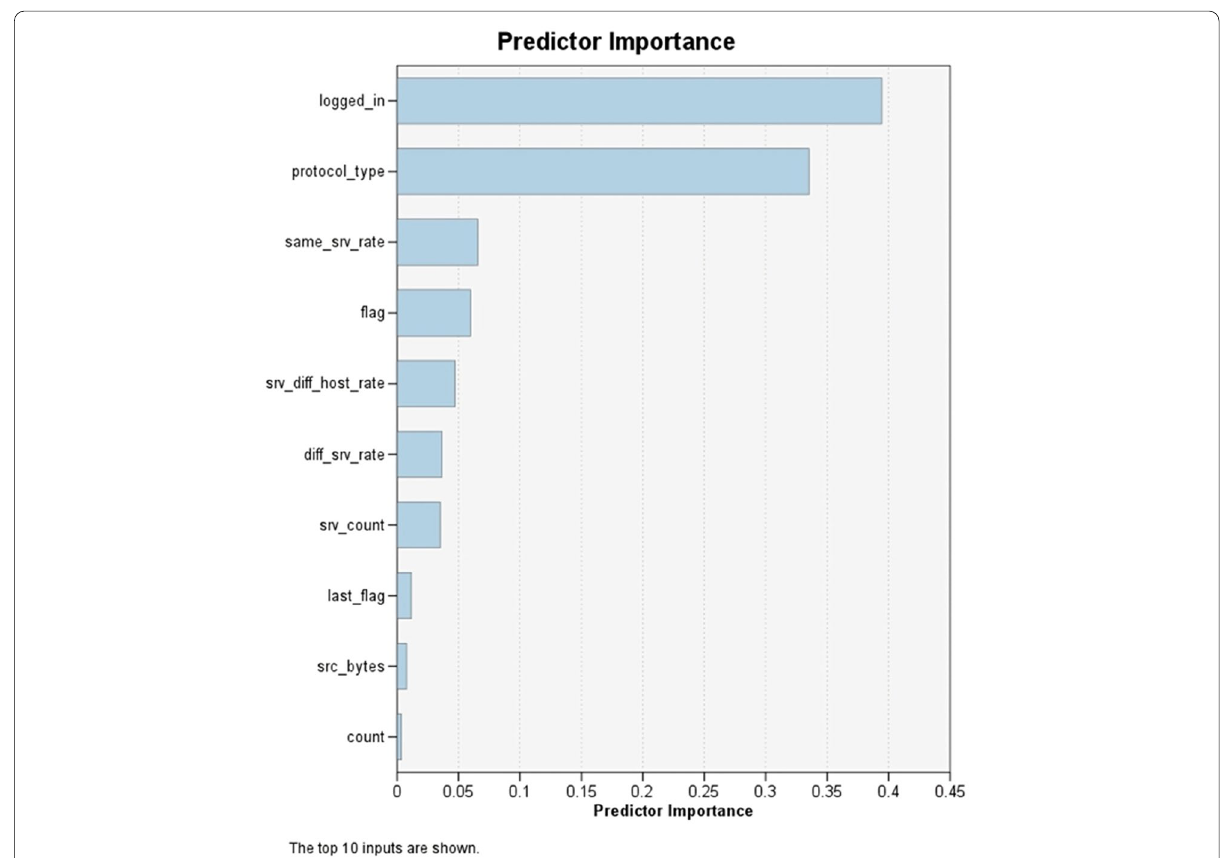
Figure 9 highlights the Condition Probabilities for Bayesian Network. It has following disadvantages as given